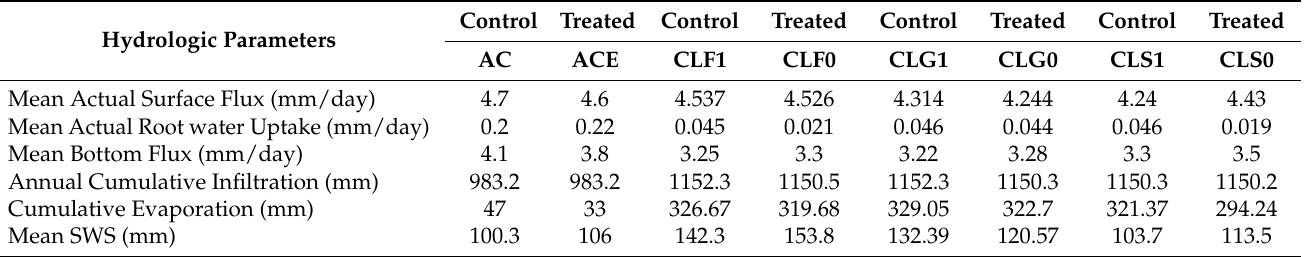
Table 2. Summarized Hydrus 1D simulation results of major water balance components in in treated and control